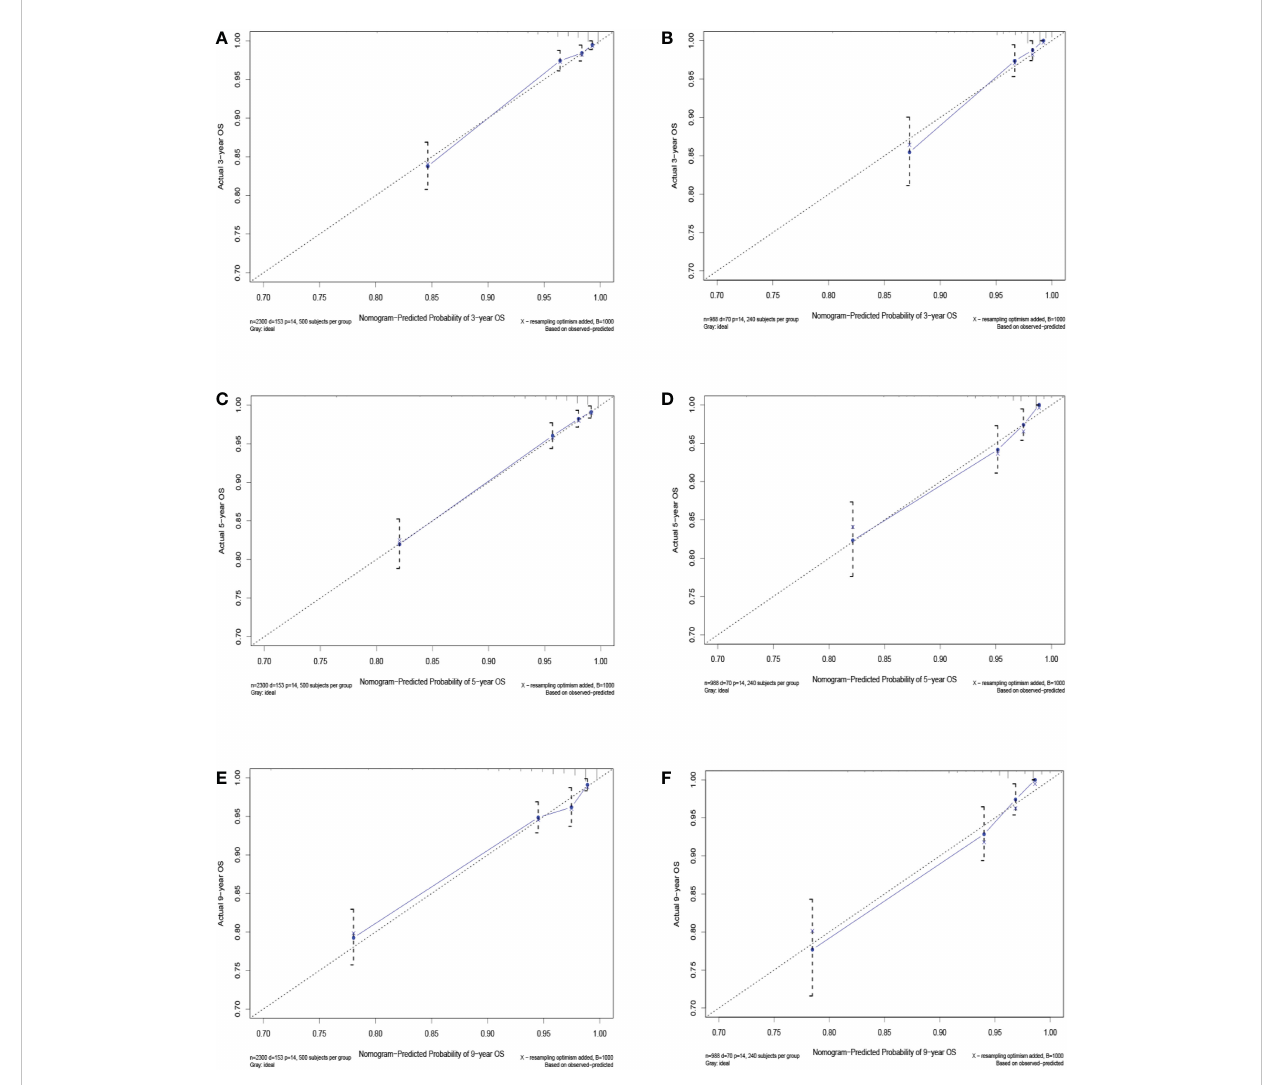
FIGURE 4 Calibration curves for 3-, 5-, and 9-year overall survival of TGCT-LVI patients in the training cohort (A, C, E) and the validation cohort (B, D, F) .